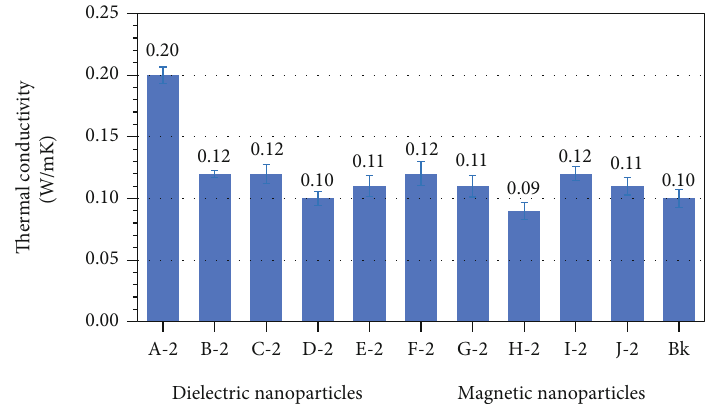
Figure 8: E ff ect of magnetic and dielectric nano fi llers on thermal (A: MWCNTs, B: SiC, C: Gp, D: CB, E: MnO ZiO, J: Fe O , and Bk: reference sample). 2 3